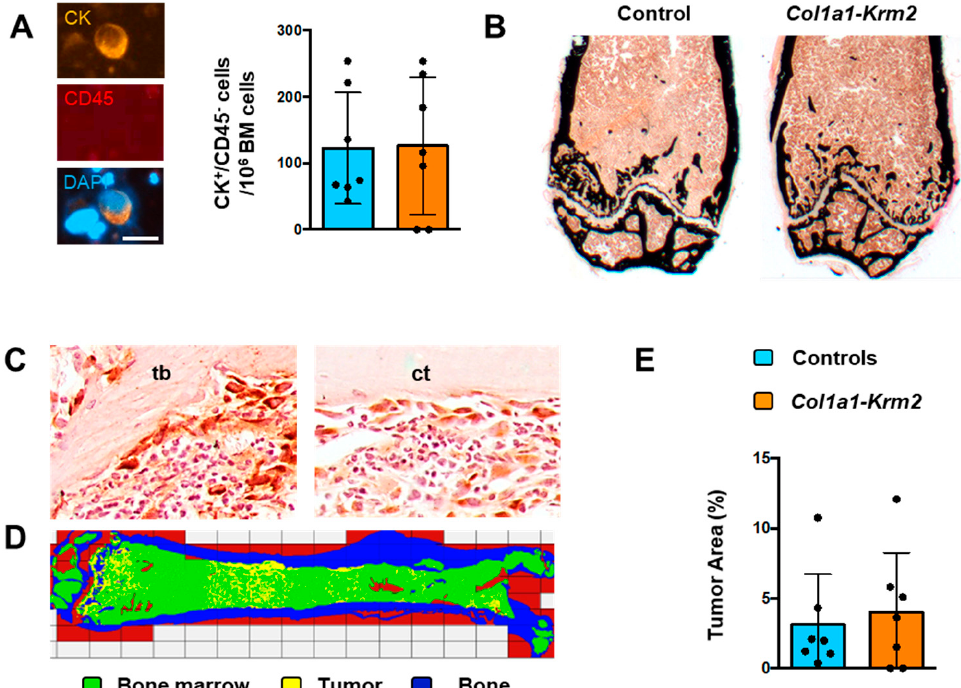
Figure 2. The Col1a1-Krm2 transgene does not affect metastatic outgrowth in femora of NSG mice. ( A ) Staining (left) and quantification (right) of human breast cancer cells (positive for cytokeratin, CK; negative for CD45) on cytospin slides from bone marrow of NSG mice (WT) and Col1a1-Krm2 -transgenic NSG mice ( Col1a1-Krm2 ) three weeks after injection of MDA-MB-231-SCP2 cells. ( B ) Representative von Kossa staining of undecalcified femur sections from the same mice. Mineralized bone is stained in black. ( C ) Representative immunohistochemistry with a cytokeratin-specific antibody for detection of human breast cancer cells in trabecular (tb) and cortical (ct) bone regions in femur sections of an injected NSG mouse. ( D ) Tumor cell distribution in a representative femur of an injected NSG mouse. Areas representing bone, unaffected bone marrow or infiltrated tumor cells are indicated by pseudocolours. ( E ) Quantification of the tumor area in femur sections of all experimental mice. Data represent mean ± standard deviation ( n = 7). Statistical significance was determined by Student’s t -test.